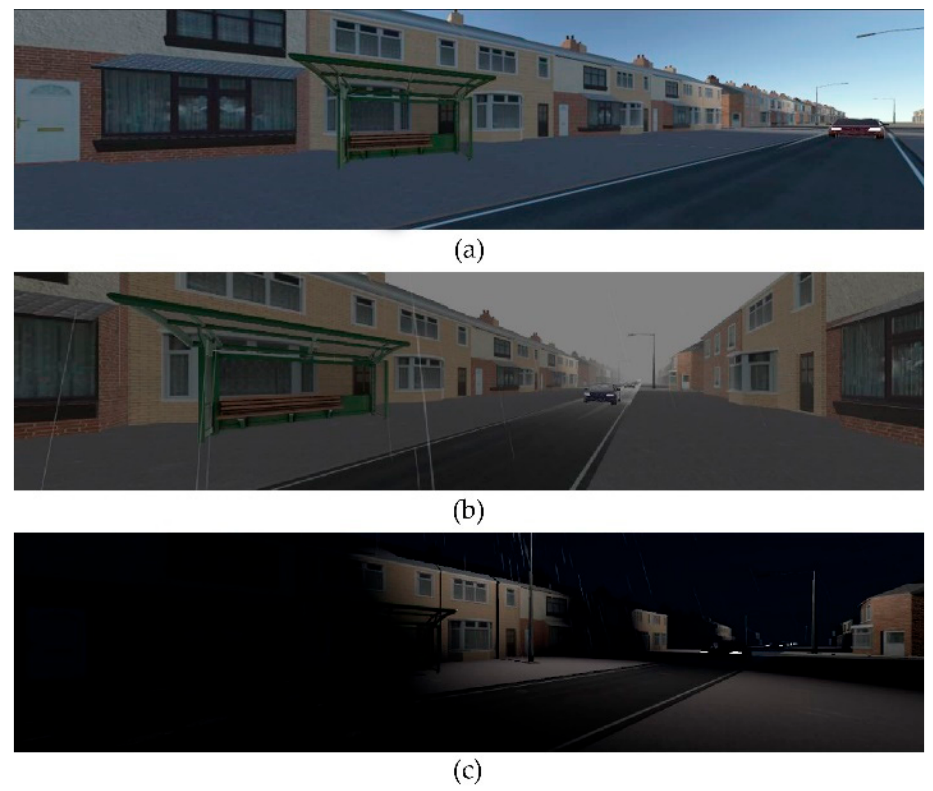
Figure 1. Example scenarios of different weather and visibility conditions: ( a ) daylight, good weather ( b ) daylight poor weather and visibility, ( c ) dusk, poor weather and visibility.